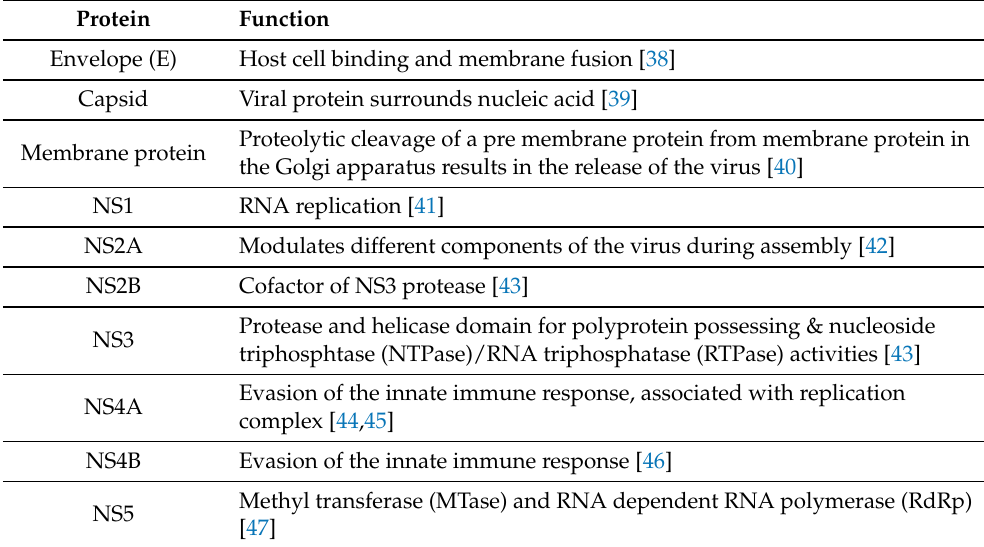
Table 1. Zika viral proteins and their